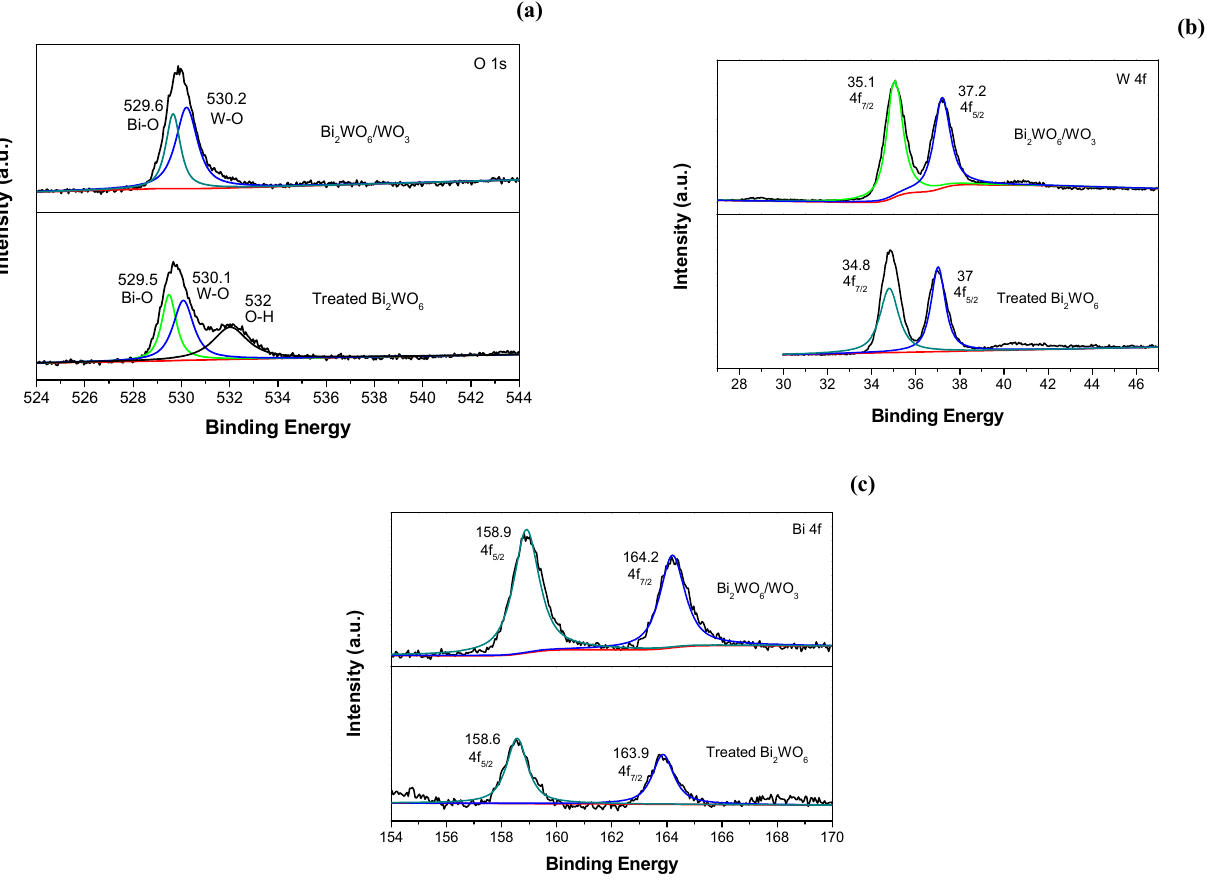
Figure 6. XPS spectra of parent and photohydrothermally treated Bi 2 WO 6 /WO 3 (natural light, CR = 600, 5 h): ( a ) O 1s; ( b ) W 4f; ( c ) Bi 4f.